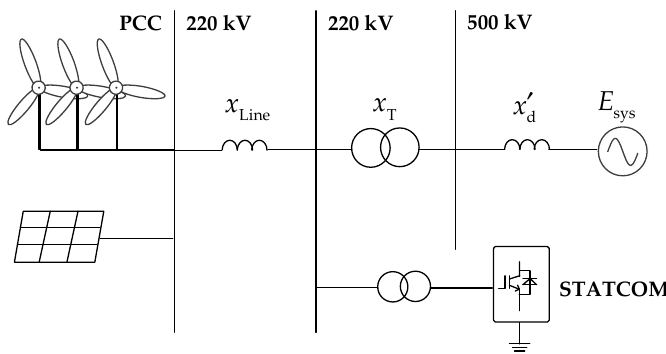
Figure 8. Schematic diagram of the system with new energy sources and STATCOM.